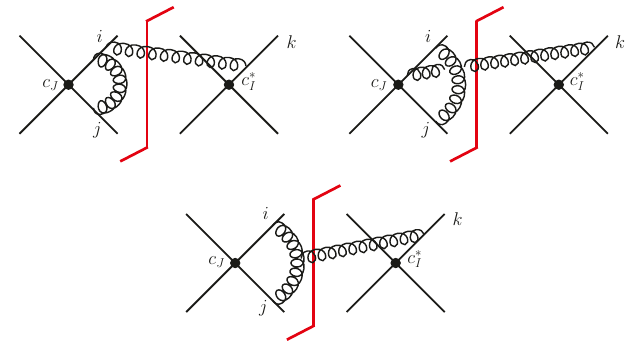
Figure 7 . Three-Wilson-line virtual-real